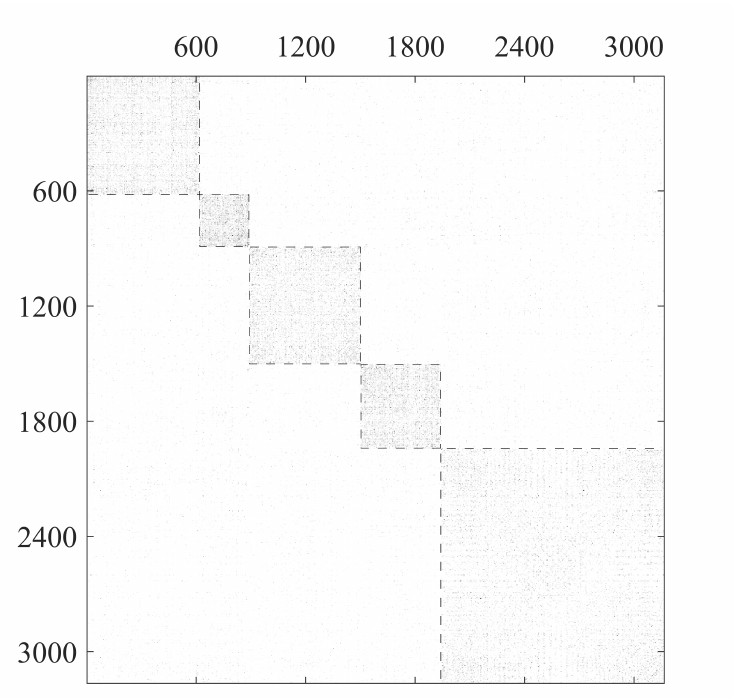
Figure 3. Visualization of the similarity matrix. Non-zero entries in the matrix are painted black, while zero entries are not colored. The numbers aside are the indexes of permutated geographical units. Dashed lines are added to highlight the five darker